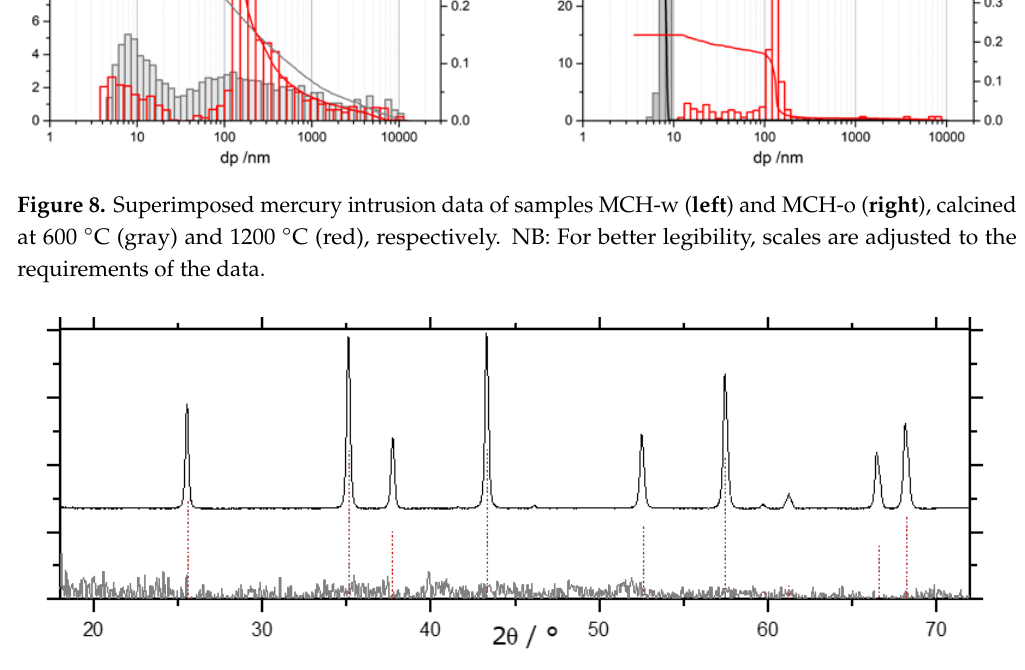
Figure 9. XRD patterns of sample MCH-w, calcined at 600 °C (gray) and 1200 °C (black), respectively. Red dotted lines indicate α -Al 2 O 3 reflexes.